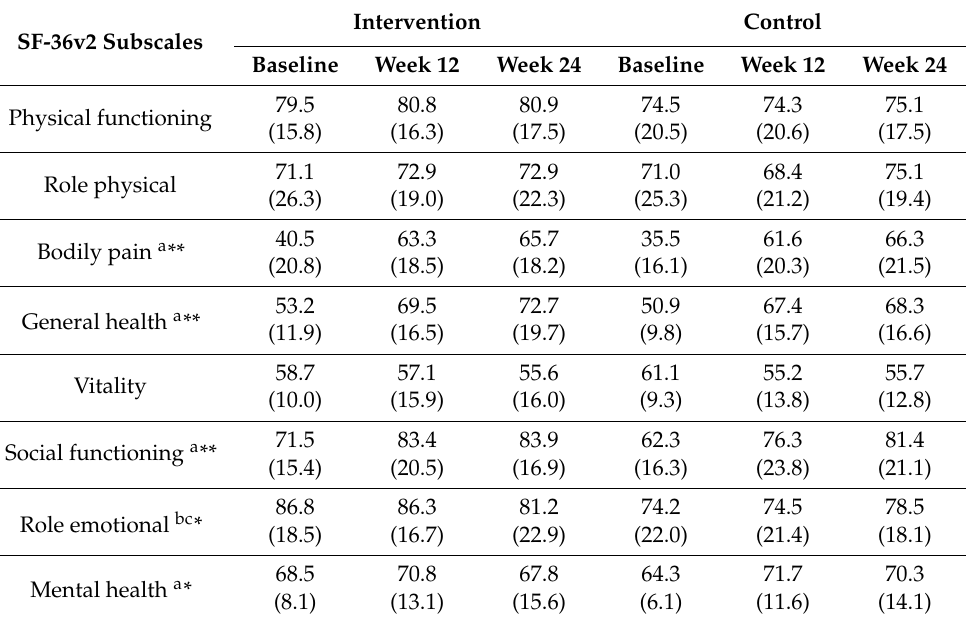
Table 5. SF-36v2 subscales for intervention and control groups at baseline, week 12, and follow-up. Intervention SF-36v2 Subscales